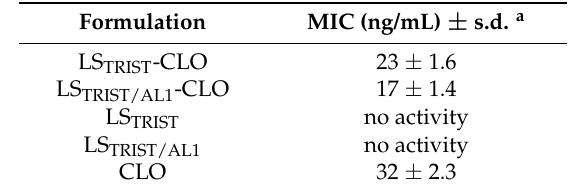
Table 4. Minimum inhibitory concentration values (MIC, ng/mL) of clotrimazole-loaded lipospheres against Candida albicans ATCC